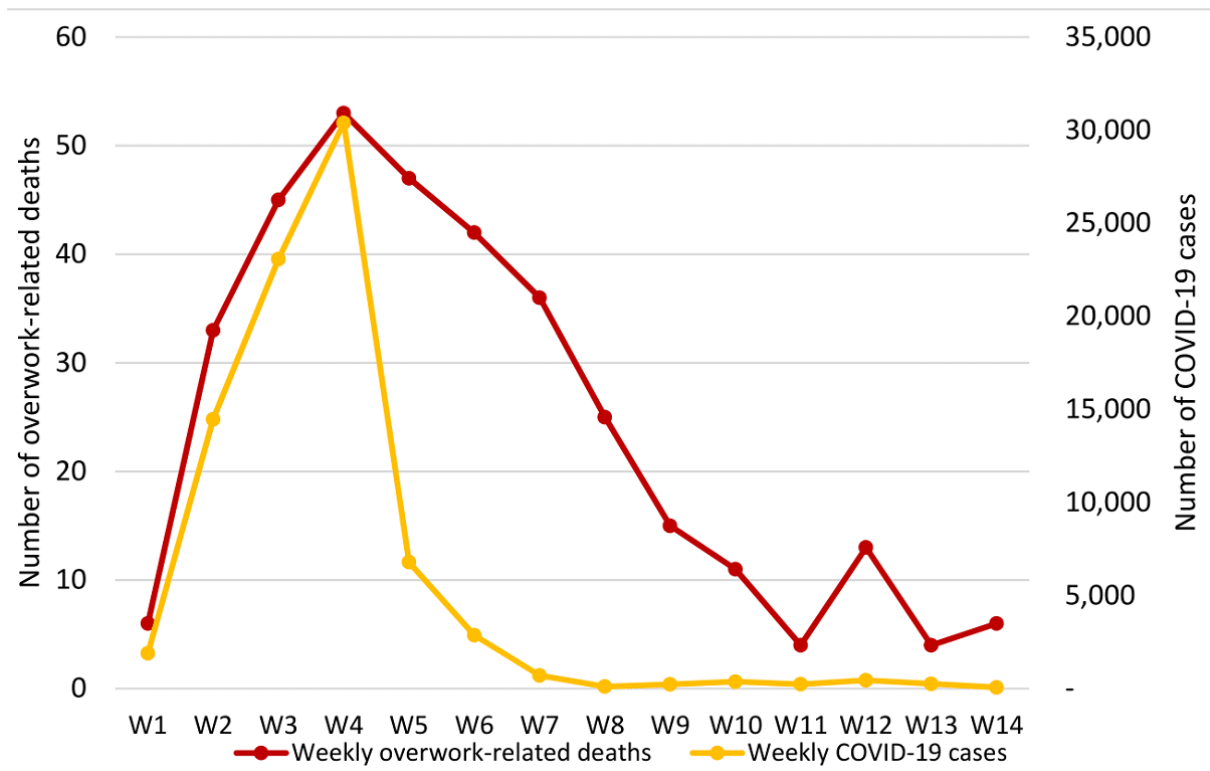
Figure 1. Trends of weekly overwork-related deaths and COVID-19 incidence between January 20 and April 26, 2020, in